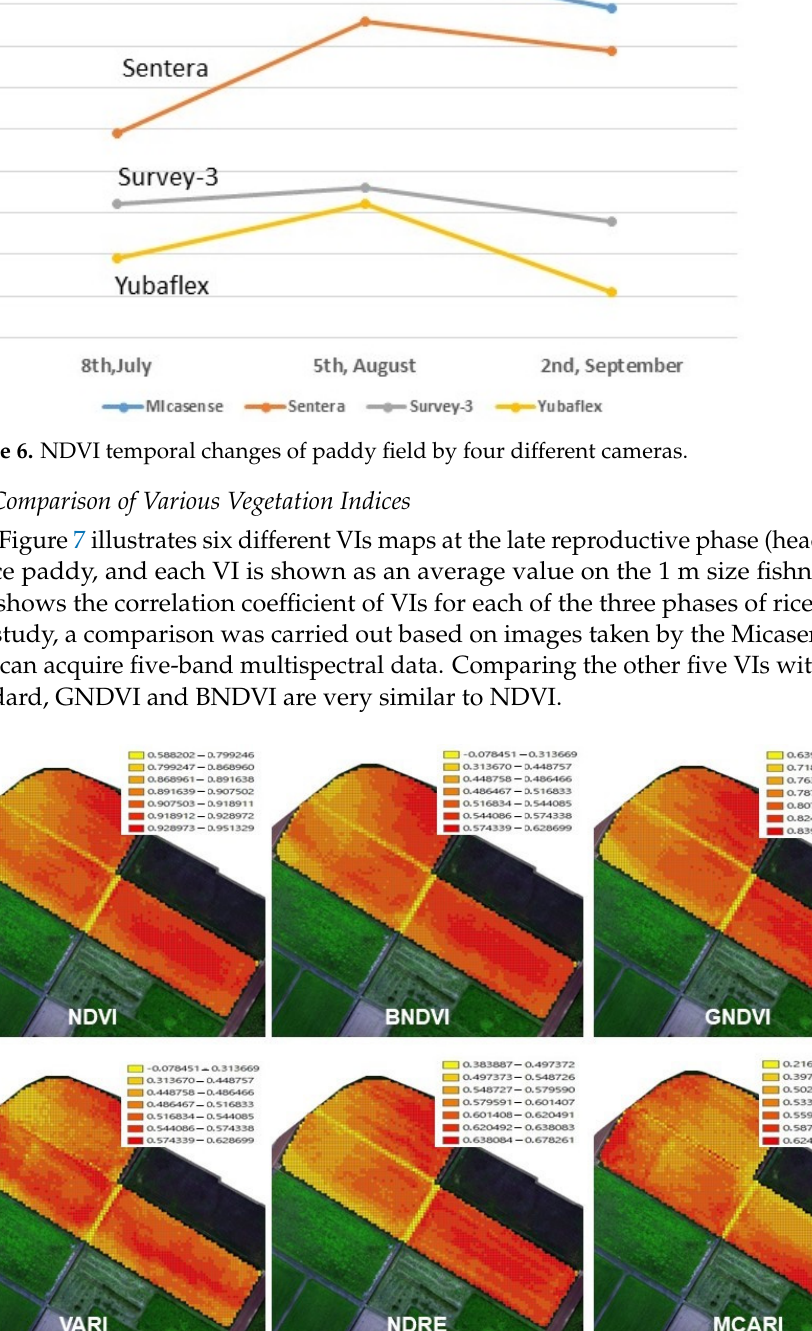
Figure 7. Comparison of six different index images of paddy field (5th August 2020, heading stage) .